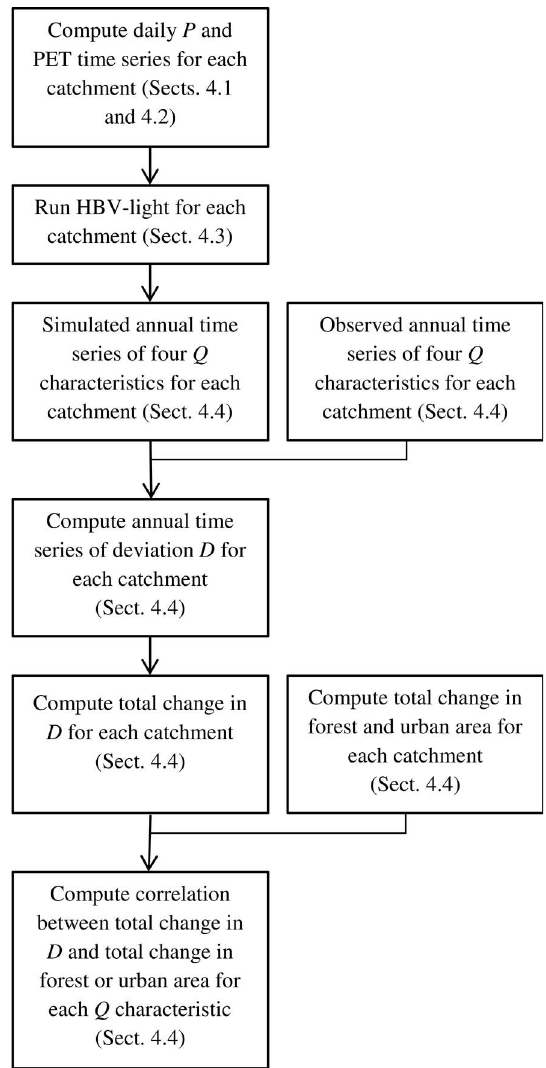
Fig. 3. Flow diagram summarizing the various steps that were car- ried out to examine whether changes in forest and/or urban area have influenced the observed Q